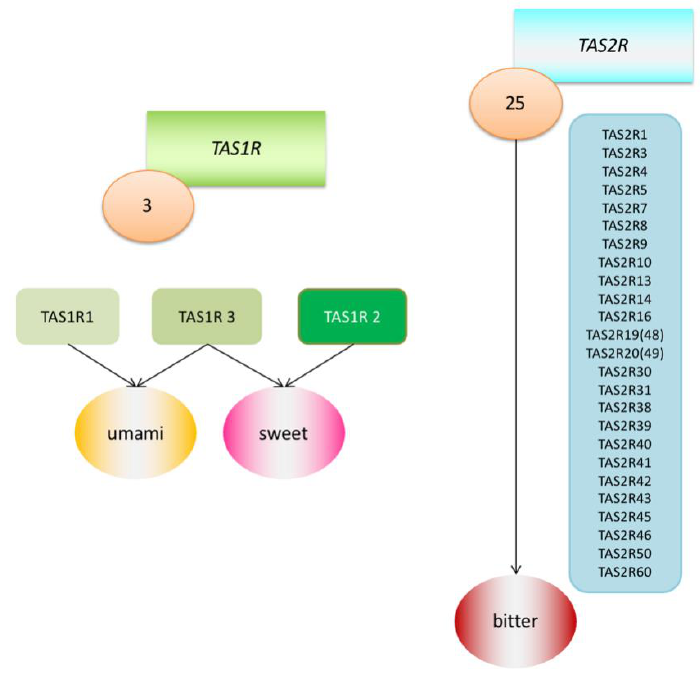
Figure 1. Graphic model of Tas1r (TAS1R1, TAS1R2, TAS1R3) and TAS2R (25 TAS2Rs ) receptor families. Table 1. Selected studies on TAS2R receptors in different human tissue lines.